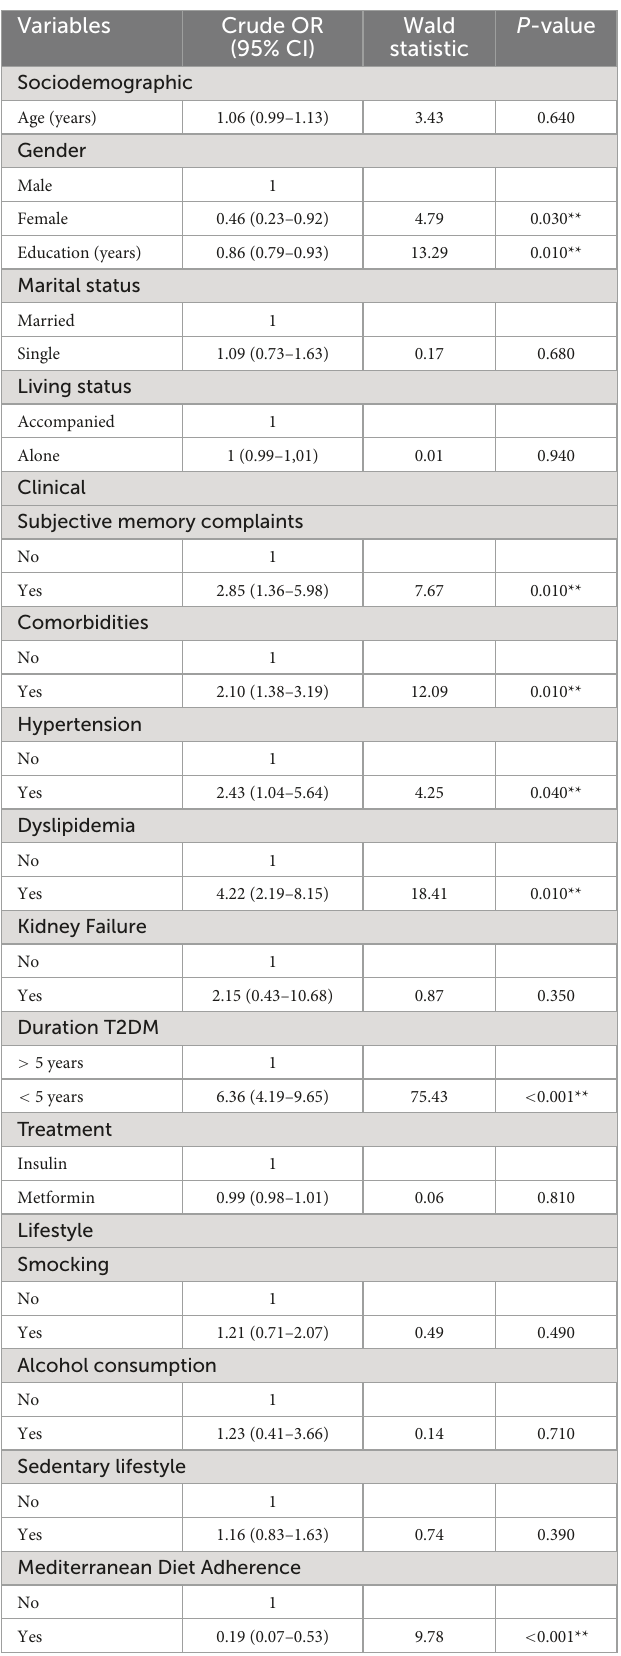
TABLE 4 Single logistic regression analysis of associations between Type 2 Diabetes Mellitus with Cognitive Impairment participants and sociodemographic, clinical, and lifestyle variables.